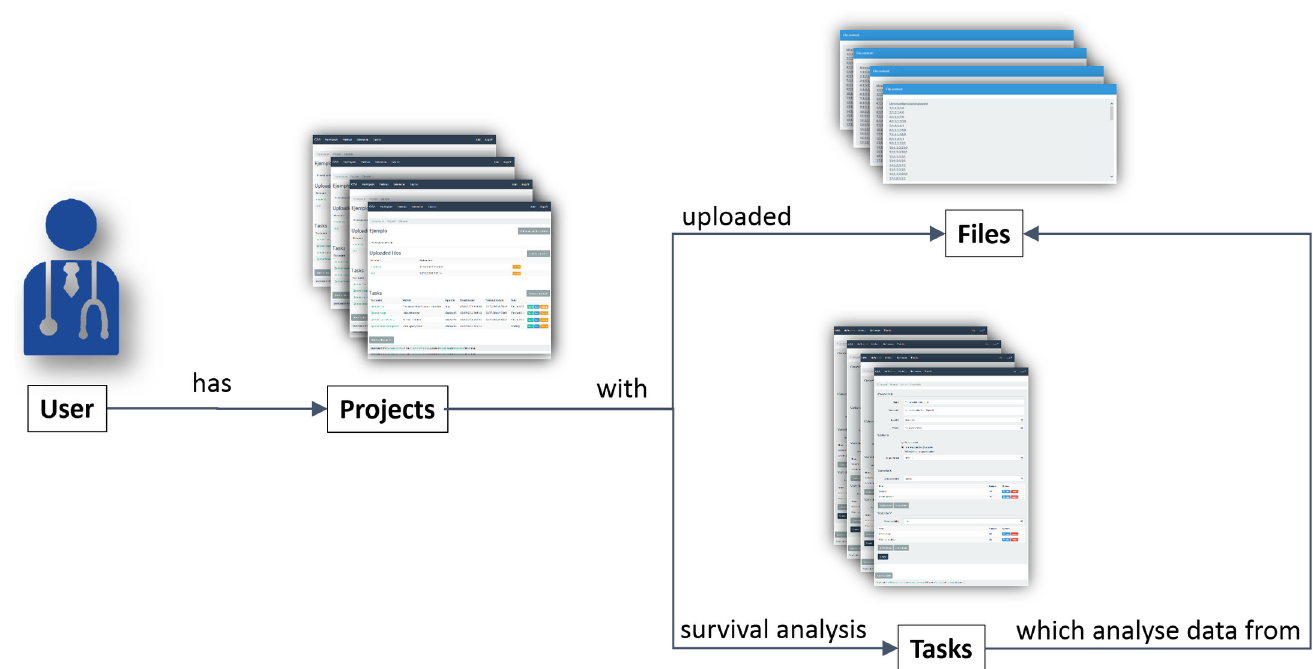
Fig 1. Simplified application structure diagram. This figure shows the main entities involved in the application workflow and their